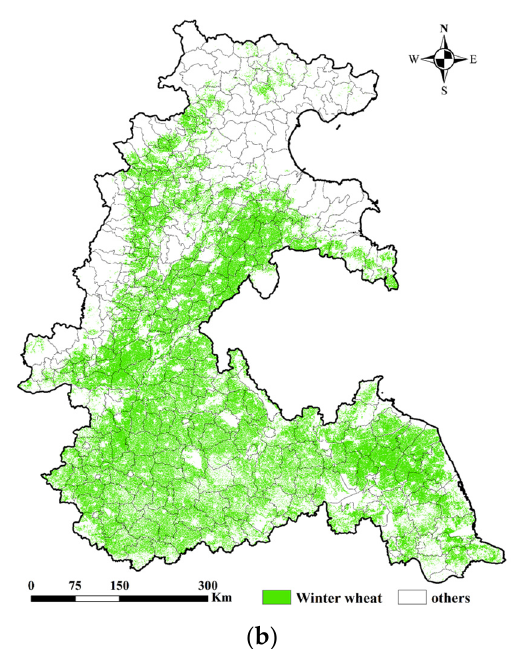
Figure 6. Winter wheat mapping results for (a) Kansas in 2017 and (b) the NCP in 2012.